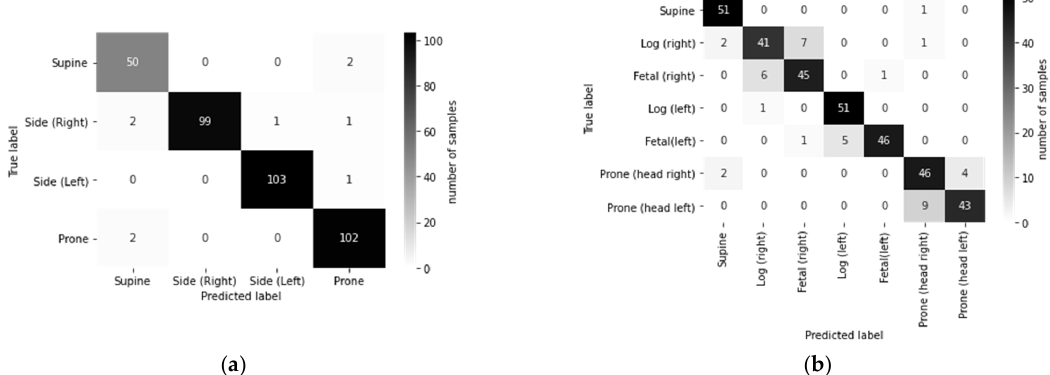
Figure 5. Confusion matrix across true and predicted labels for ( a ) 4-posture coarse-grained classification and ( b ) 7-posture fine-grained classification.